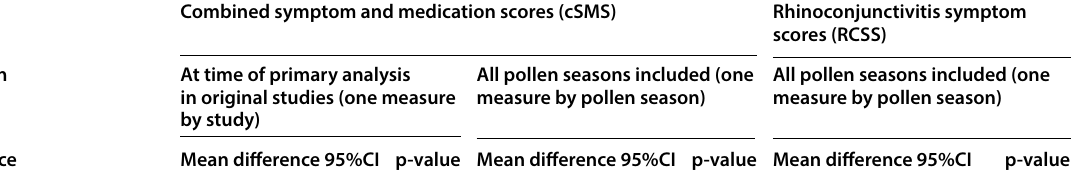
Table 5 Meta-regression results Combined symptom and medication scores (cSMS) Rhinoconjunctivitis symptom Meta-regression